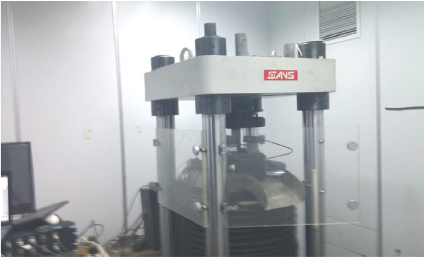
Figure 1: Experimental